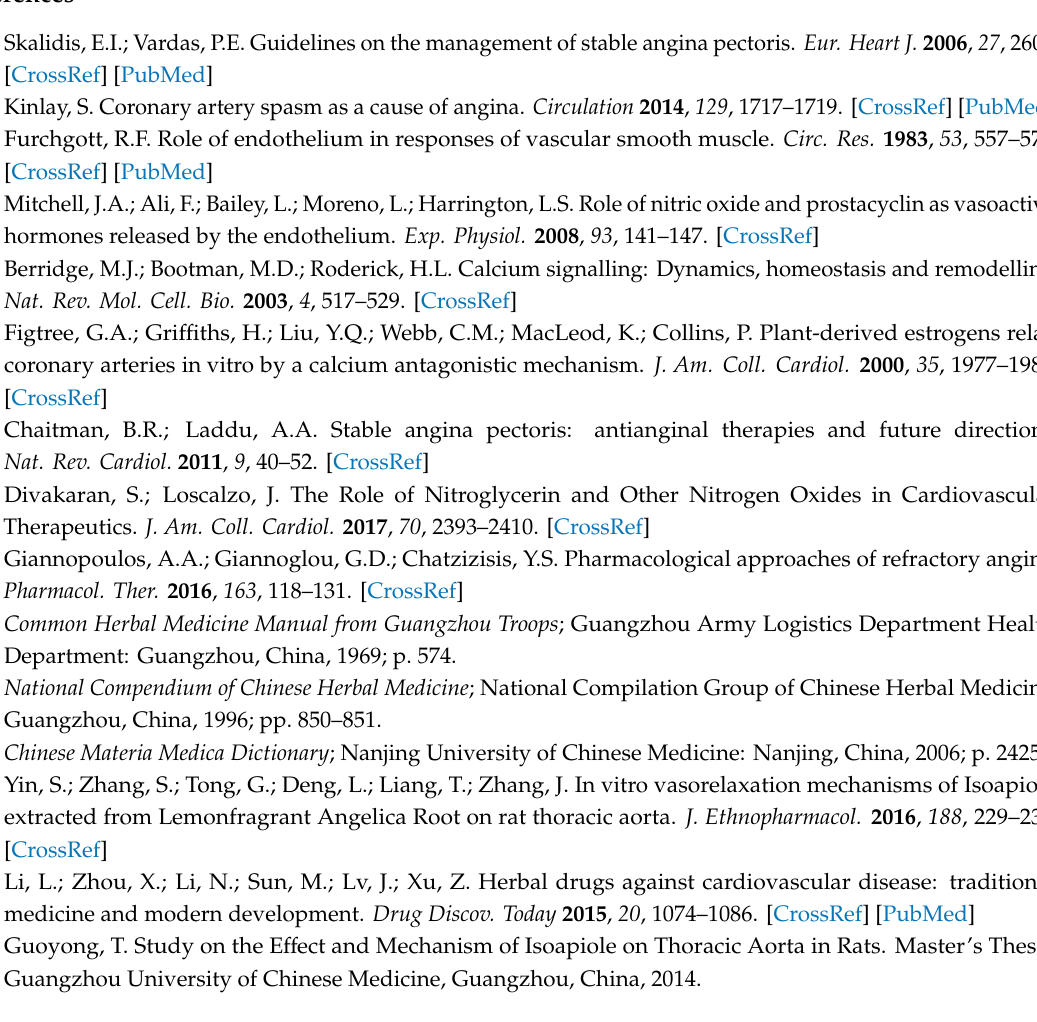
3, Figure S12: 1 H-NMR spectrum of compound 4, Figure S13: 13 C-NMR spectrum of compound 4, Figure S14: 1 H-NMR spectrum of compound 5, Figure S15: 13 C-NMR spectrum of compound 5, Figure S16: 1 H– 1 H COSY spectrum of compound 5, Figure S17: HSQC spectrum of compound 5, Figure S18: HMBC spectrum of compound 5, Figure S19: 1 H-NMR spectrum of compound 6, Figure S20: 13 C-NMR spectrum of compound 6, Figure S21: 1 H-NMR spectrum of compound 7, Figure S22: 13 C-NMR spectrum of compound 7, Figure S23: Key 1 H– 1 H COSY and HMBC correlations of compound 8, Figure S24: 1 H-NMR spectrum of compound 8, Figure S25: 13 C-NMR spectrum of compound 8, Figure S26: COSY spectrum of compound 8, Figure S27: HSQC Spectrum of compound 8, Vasodilatory e ff ects of isodillapiolglycol: Figure S28: IDG directly caused relaxation in the vascular smooth muscle cells of aorta rings at di ff erent times. Endothelium (A) -intact or (B) -denuded aorta rings pre-contracted with NE (3 mM), endothelium (C) -intact or (D) -denuded aorta rings pre-contracted potassium chloride (KCl) (60 mM). Values are means ± SEM ( n = 6). Relaxation for IDG at 10 min was compared with relaxation after pre-incubation for 20 and 30 min using two-way ANOVA. Note: * p < 0.05 vs. 20 min group; # p < 0.05 vs. 30 min